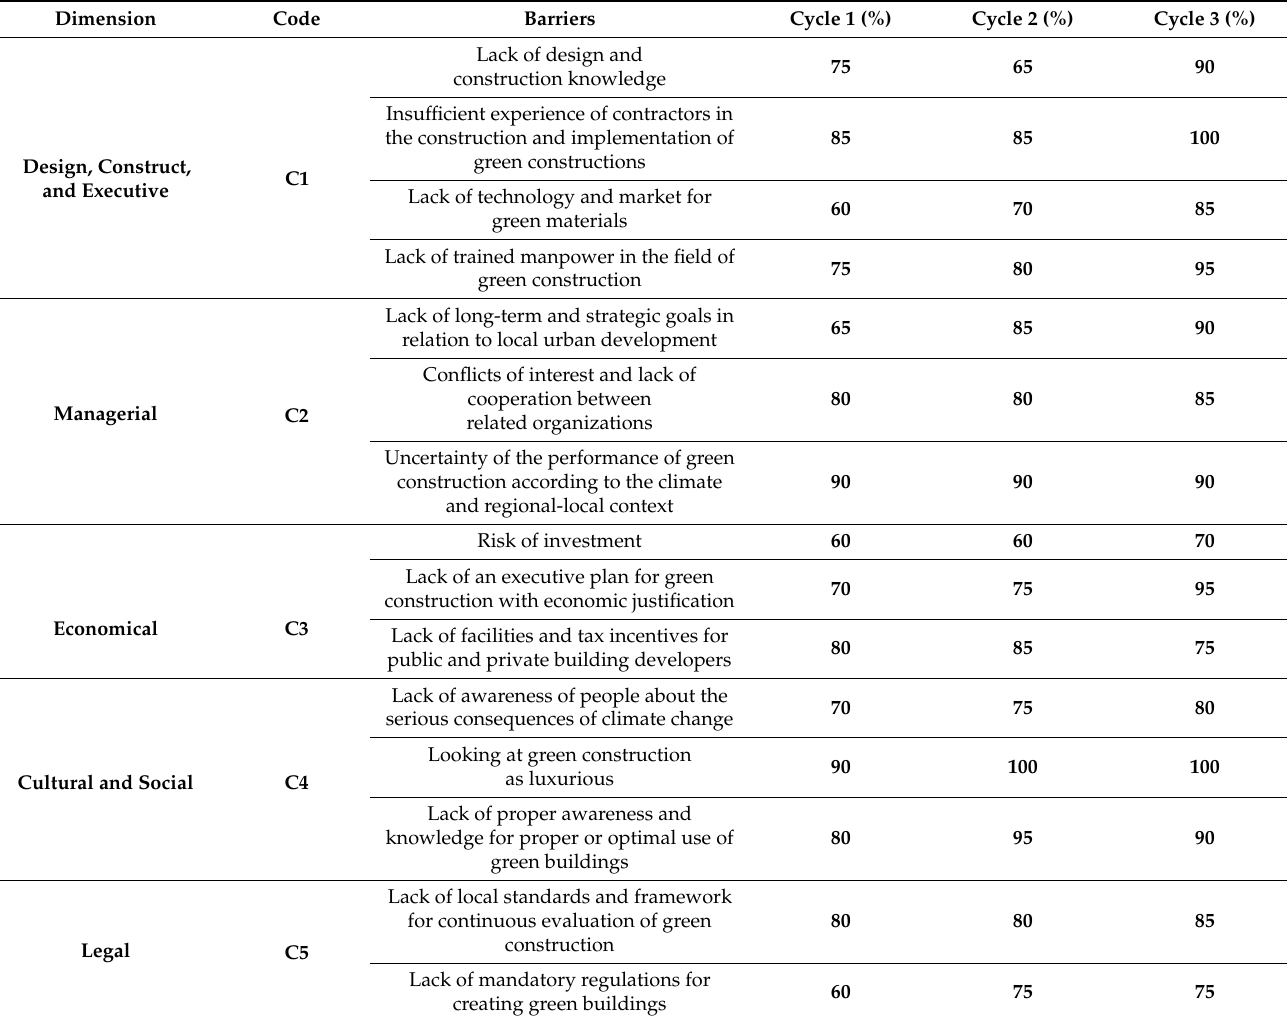
Table 2. Identification of barriers and experts’ agreement during different cycles of classical Delphi method in our